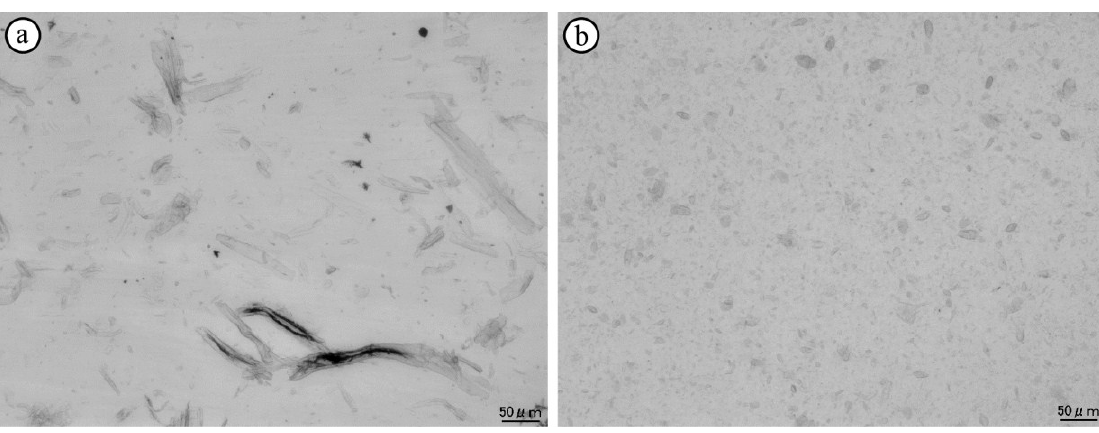
Figure 2. Optical micrographs of ( a ) wood flour and ( b ) lignocellulose nanofiber composites. The contents of wood flour and the lignocellulose nanofibers were both 5 wt%.